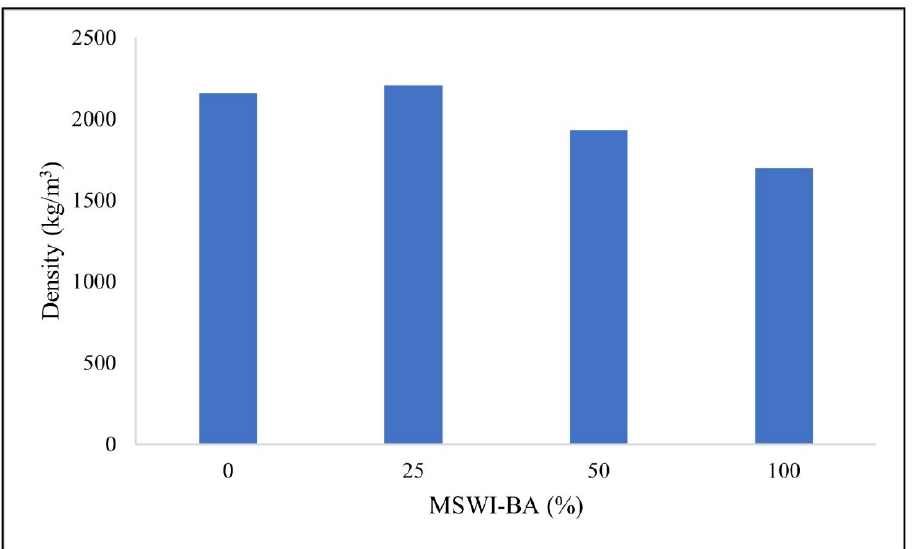
Figure 4. Density of the mortar containing MSWI-BA, redrawn from [46].